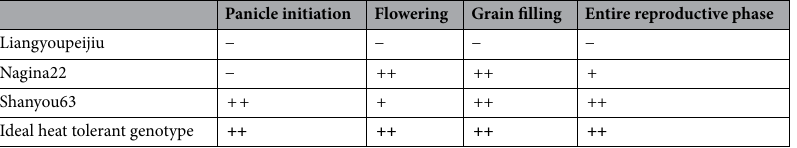
Table 3. Ideal rice genotypes with comprehensive tolerance to heat stress. −, heat sensitive; +, moderately heat tolerant; ++, heat tolerant. + in bold font indicates the more tolerant to heat stress than the rice cultivar Nagina22/Shanyou63.